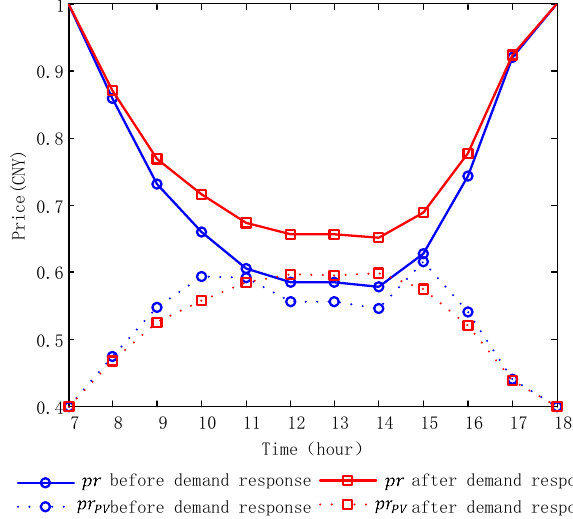
Figure 11. The comparison of internal prices before and after DR.